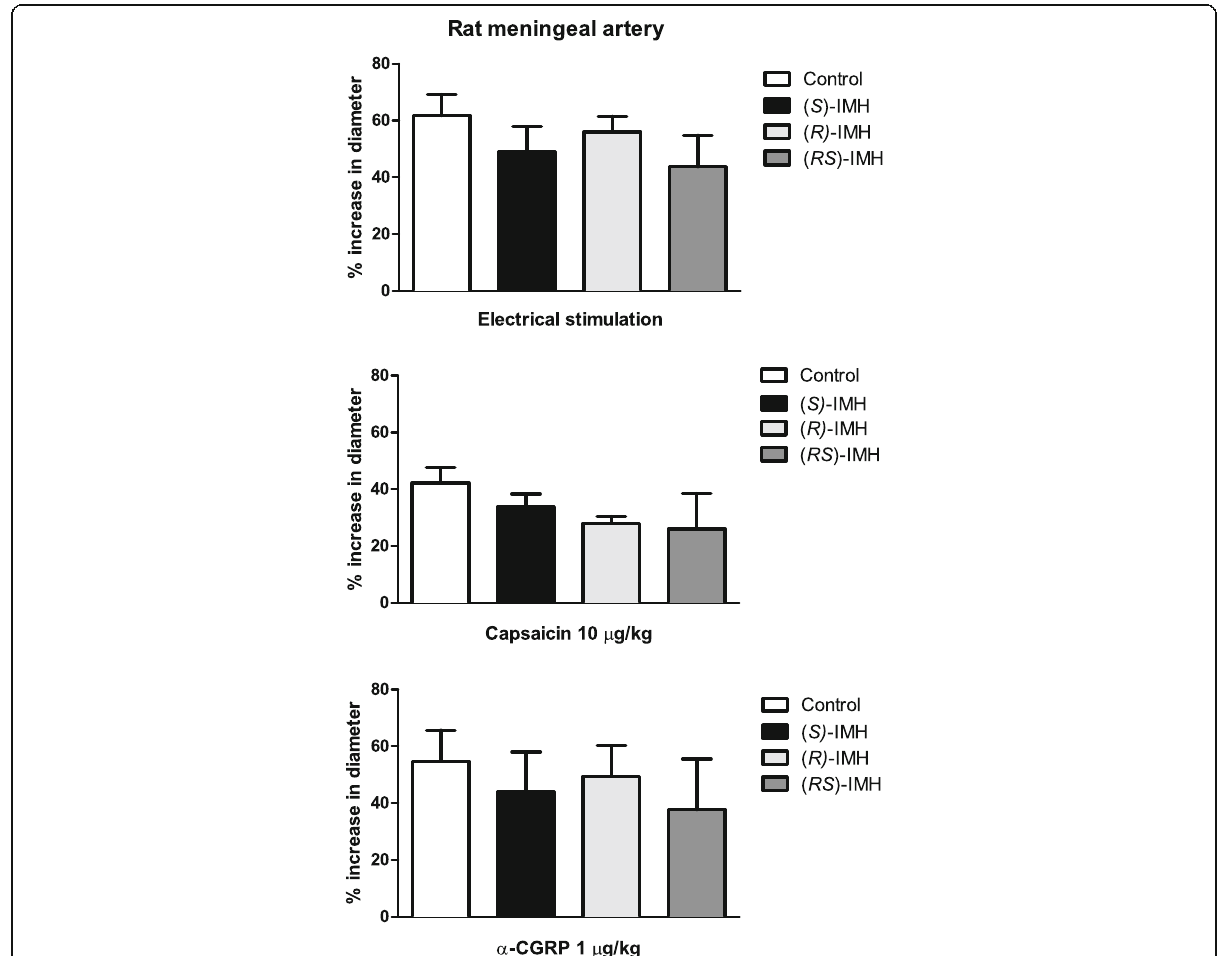
Fig. 3 Effect of i.v. bolus injections of isometheptene enantiomers or the racemate (3mg/kg) on dural vasodilation induced by periarterial electrical stimulation (150 – 300 μ A, upper panels), capsaicin (10 μ g/kg, middle panels) or α -CGRP (1 μ g/kg, lower panels) in anesthetized rats ( n =4 in each group); ( S )-IMH, ( S )-isometheptene; ( R )-IMH, ( R )-isometheptene; ( RS )-IMH, isometheptene